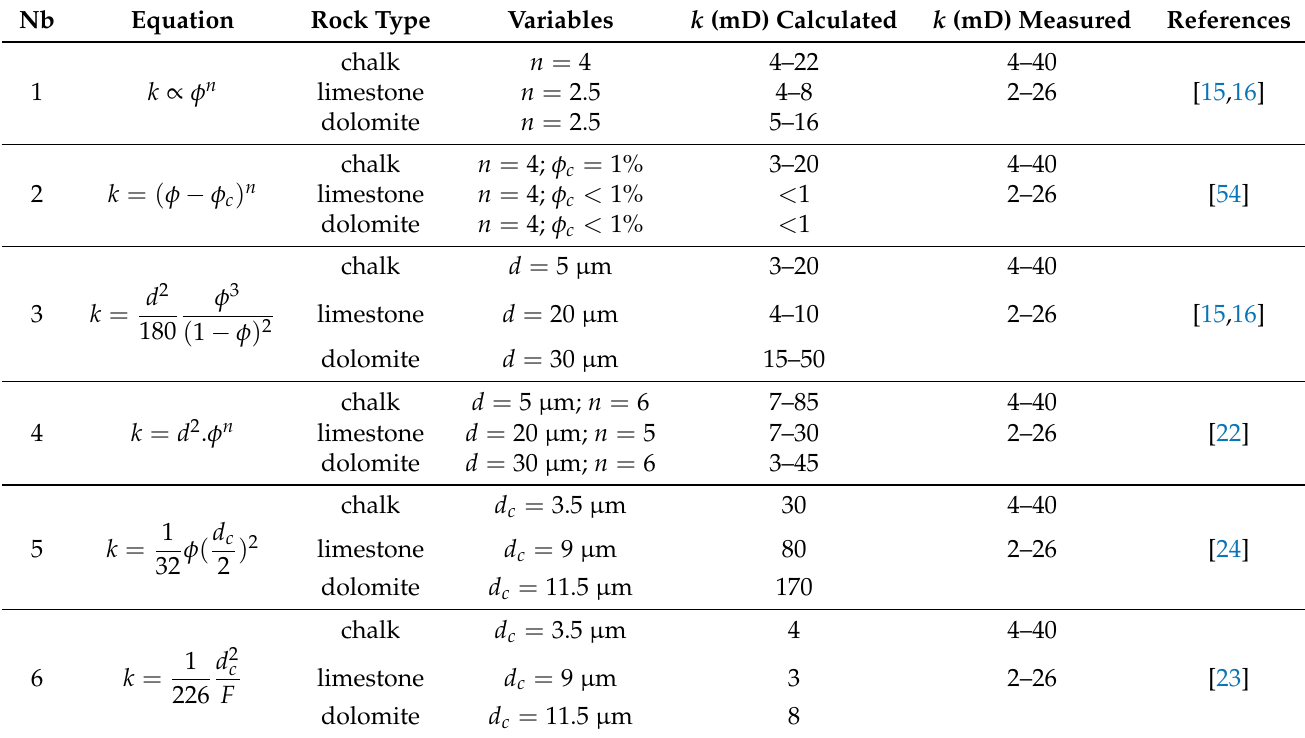
Table 4. Summary of permeability results calculated from